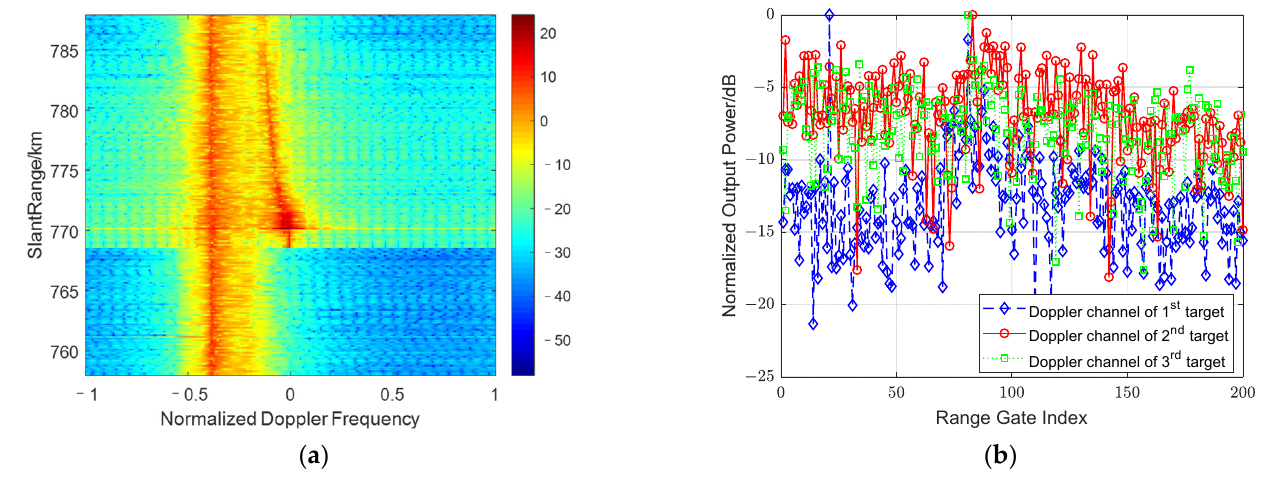
Figure 8. Output power spectrum for FDA-Phase-MIMO SBEWR after method 2: ( a ) Range-Doppler output power spectrum; ( b ) Normalized output power spectrum in different Doppler channels.